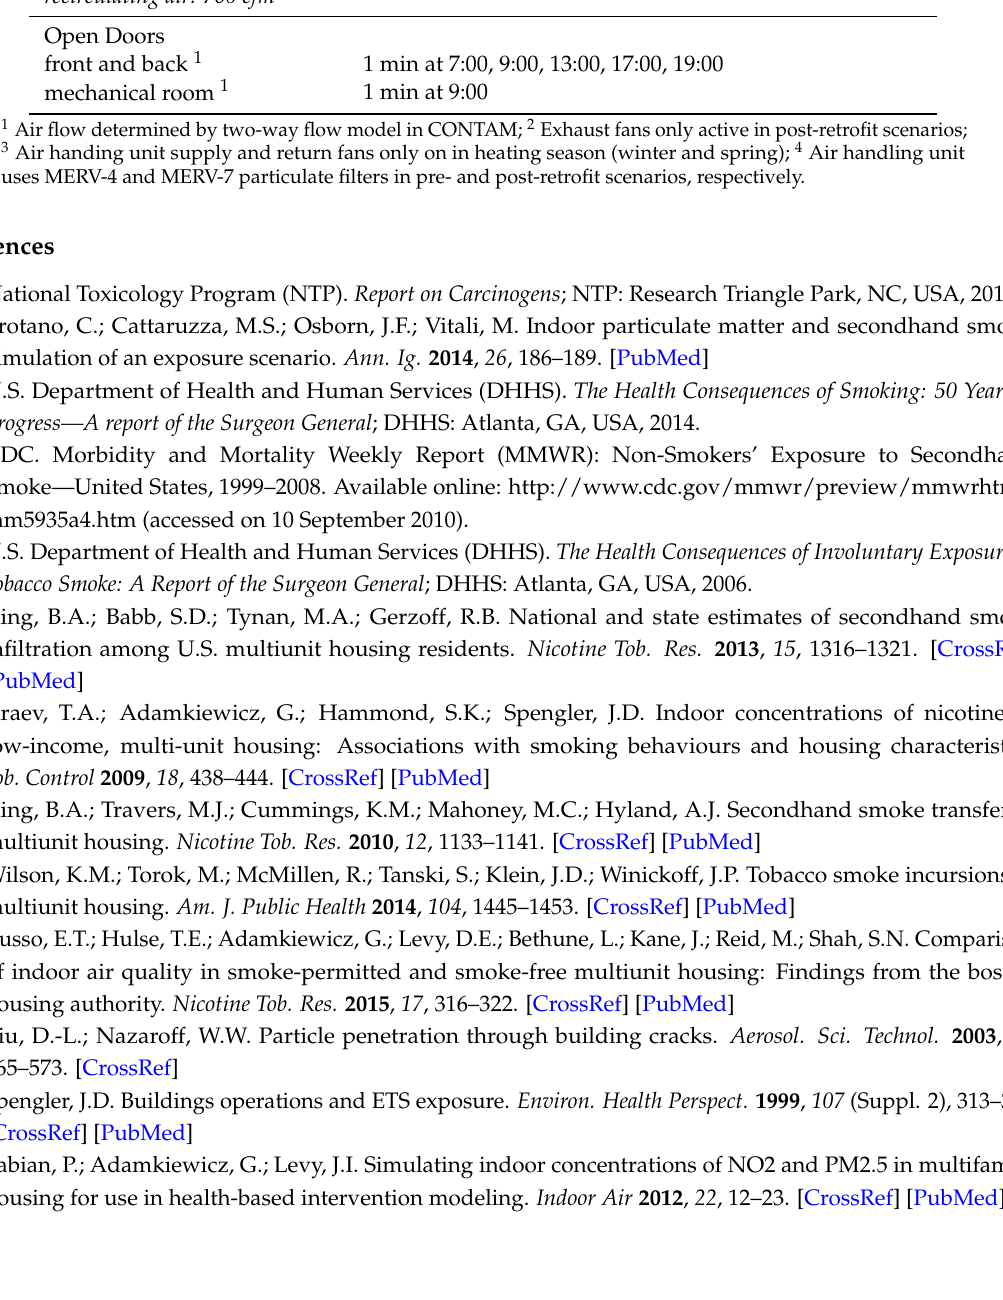
Table A3. Characteristics and schedules for the mechanical heating system, exhaust fans, door and window opening. Kitchen Schedule window open 1 schedule)exhaust fan on 2 flow rate: 160 cfm Bathroom window open